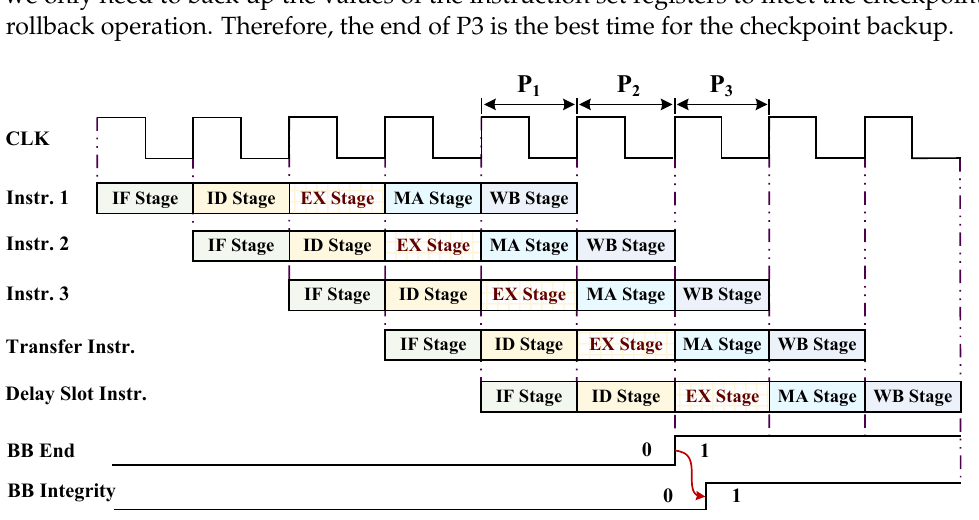
Figure 3. The timing diagram of BB instructions being executed in the five-stage pipeline